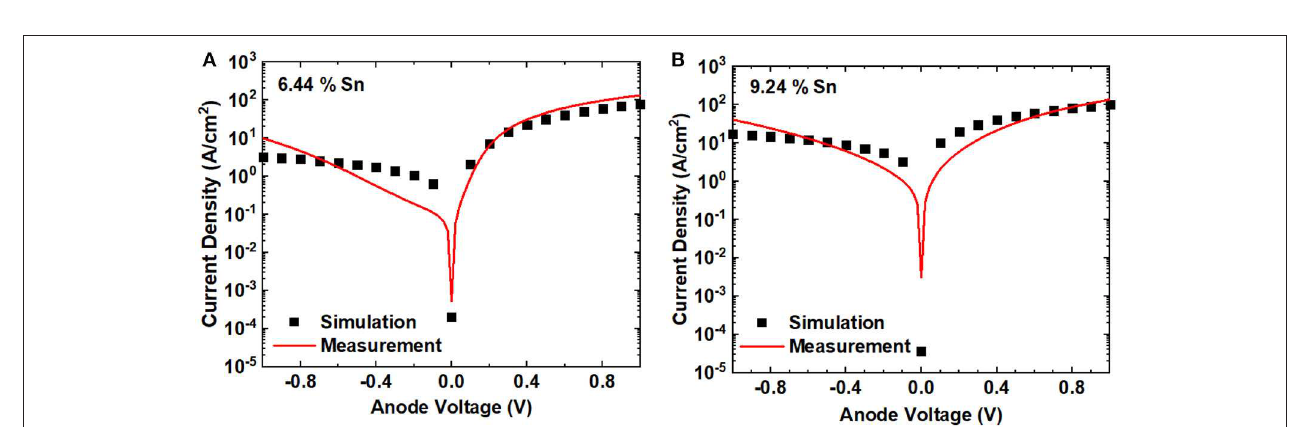
Frontiers in Materials |